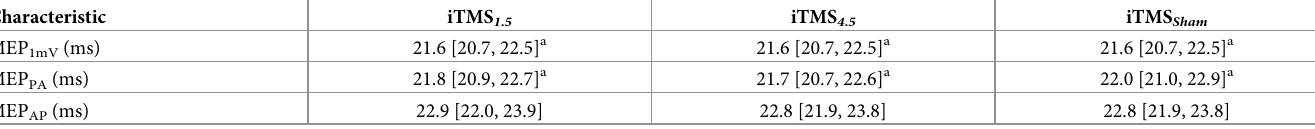
Data show mean [95%CI; lower, upper]. a P < 0.05 compared to MEP